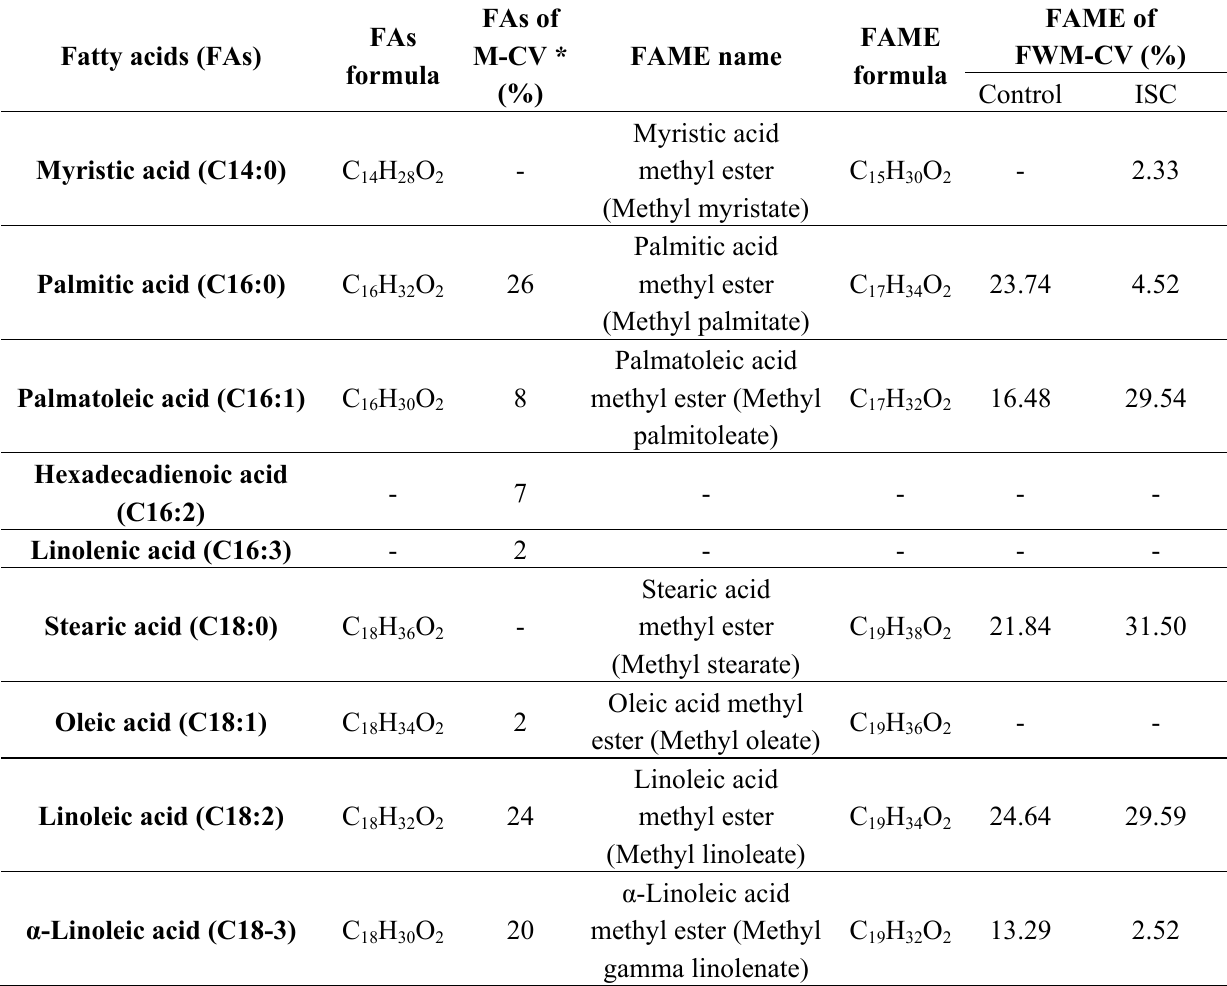
Table 3. FAMEs in C. vulgaris